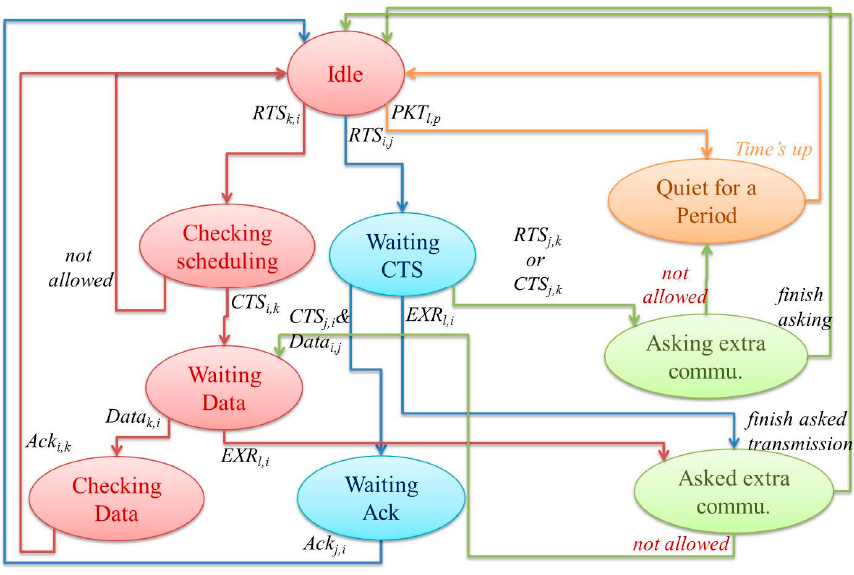
Figure 3. State transfer diagrams of sensor i.